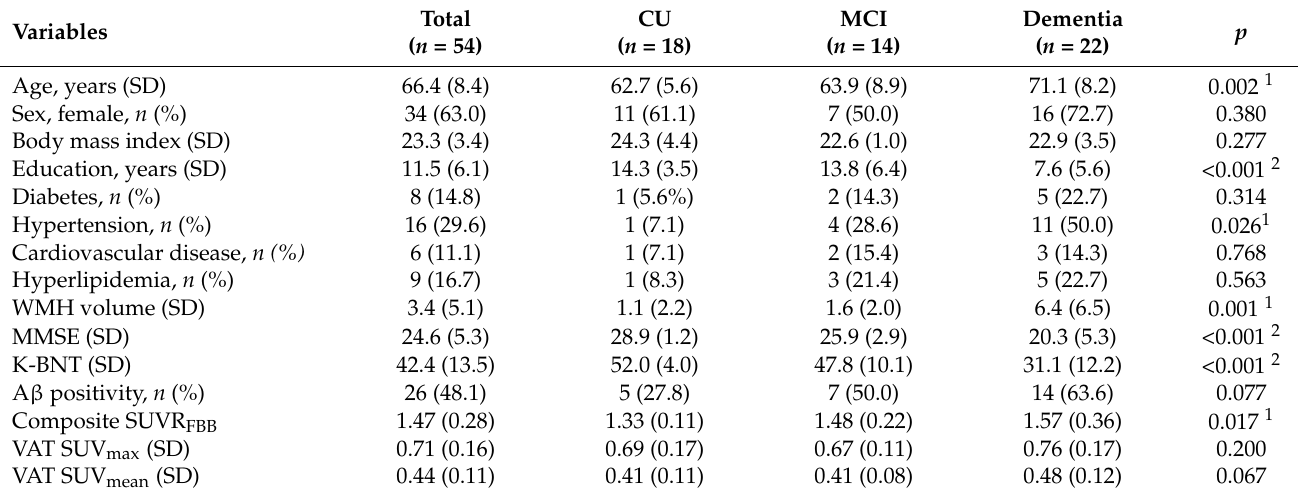
Table 1. Characteristics of the study population.